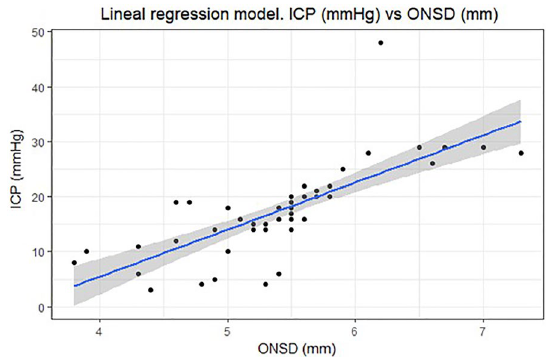
Fig. 4 Linear regression model. In the analysis of the model, it is observed that the relationship between ONSD and ICP did not reflect a linear relationship for values greater than 6 mm of ONSD